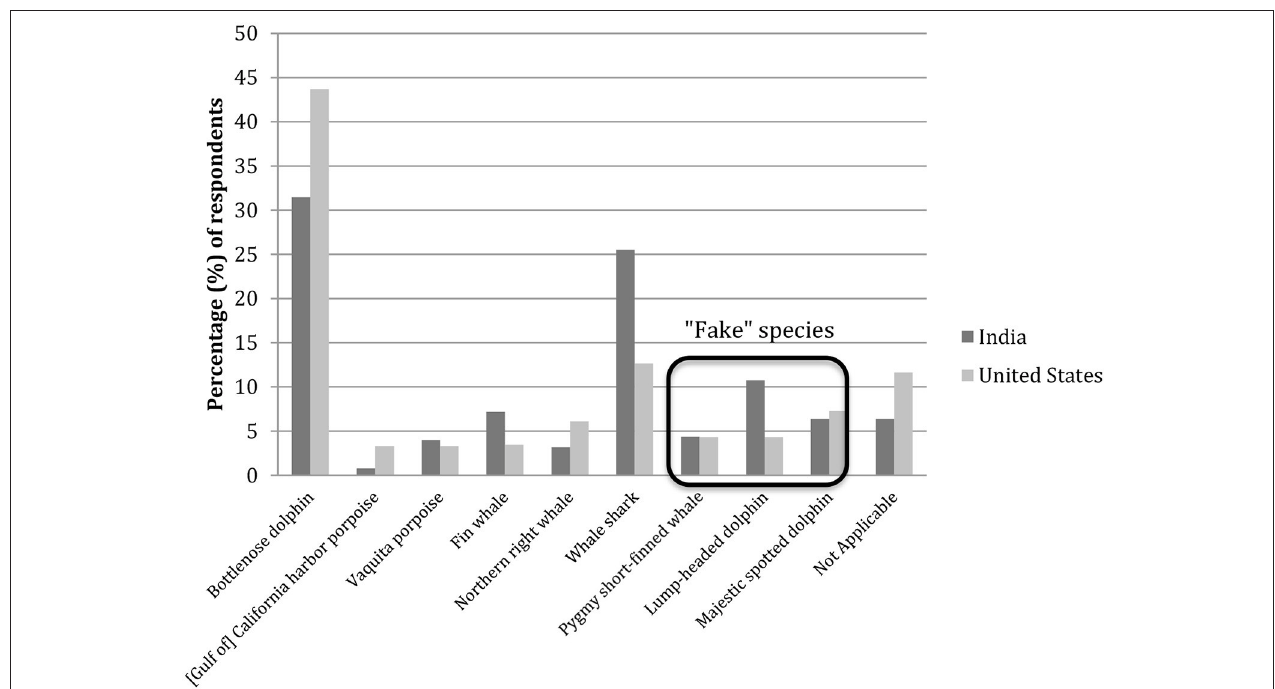
FIGURE 7 | Which dolphin/whale species listed respondents from the United States and India felt was the most important to conserve. The whale shark is not a cetacean species. The Pygmy short-fined whale, the Lump-headed dolphin, and the Majestic spotted dolphin were included as “fake” species (US, n = 577; India, n = 251).